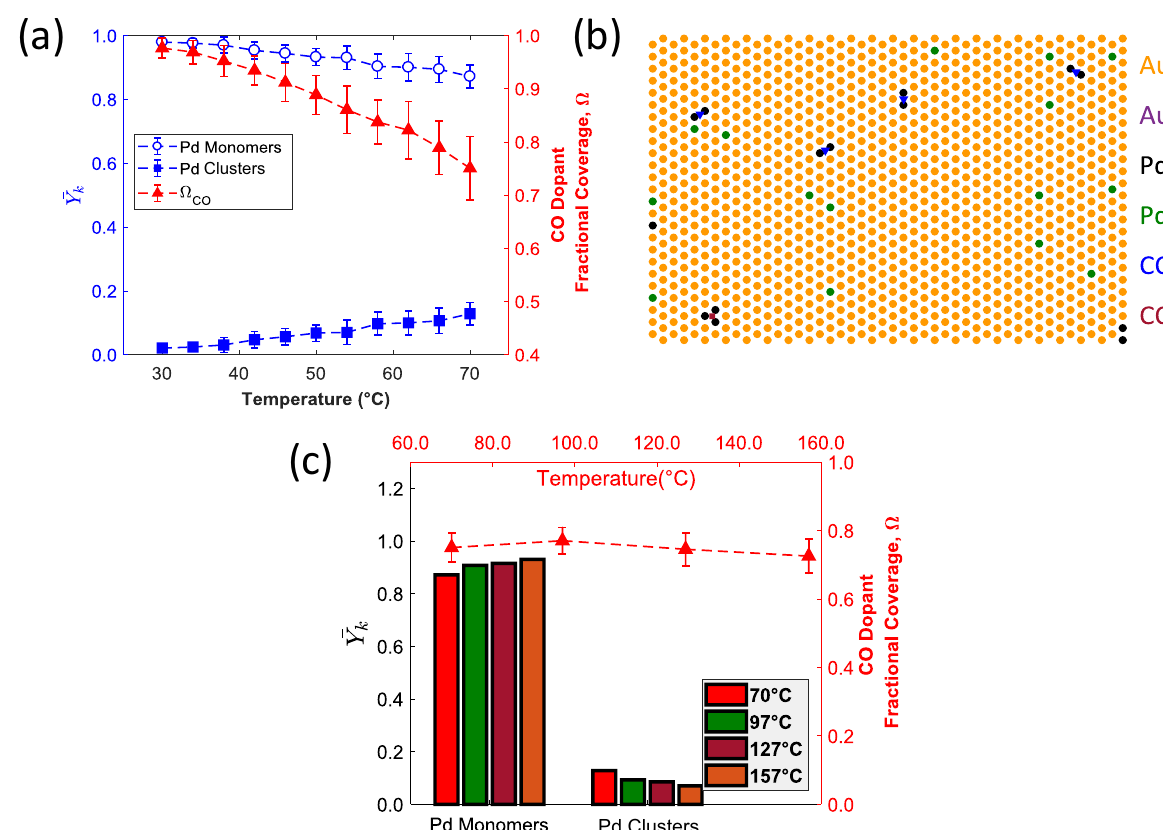
Fig. 3 Computational investigations of CO-induced Pd clusters formation in Pd/Au. a Fractions of the different surface species ( Y k ) and CO dopant fractional coverage ( Ω CO ) at temperatures within the 30 – 70 °C range for E ads (CO) on Pd surface species that are shifted by + 0.2 eV as compared to the DFT-predicted values; P CO = 0.1 bar for all calculations. b Representative MC snapshot at 70 °C that shows that the majority of Pd aggregates are Pd – Pd dimers. Pd, Au, and Pd atoms with adsorbed CO are shown in black, yellow, and green, respectively. Bridge sites between Pd atoms, Au atoms covered by CO, and empty hollow sites are shown in light green, blue, and gray, respectively. Panel ( b ) shows only part of the MC lattice. ( c ) Y k and Ω CO at four different temperatures for Ω CO ~0.75. The error bars in panels ( a ) and ( c ) are ±1 standard